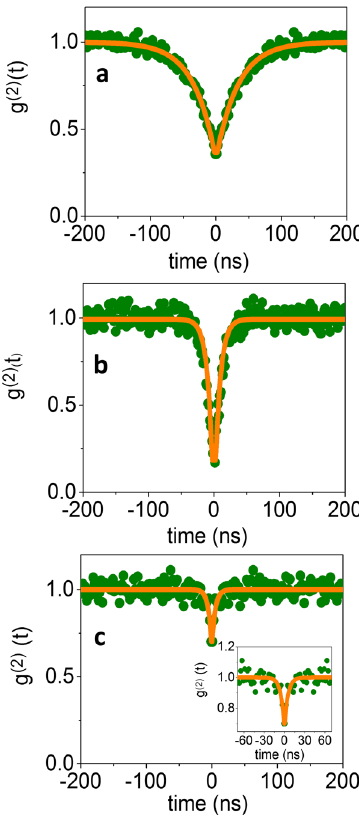
Fig. 3 Second-order photon correlation function ( g (2) ( t )). a A bare QD on glass substrate. b , c QDs coupled to PCs. The dip at zero delay is a manifestation of a single QD in ( b ) and three QDs in ( c ). Green — experimental results, orange — fi ts to Eq.